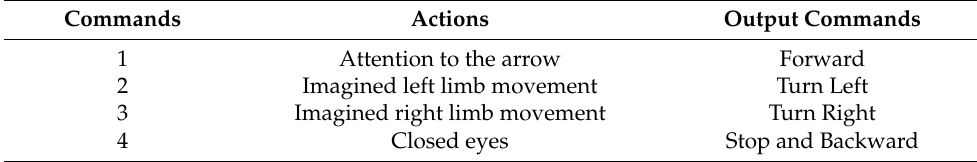
Table 1. Proposed action for mental tasks mapping with output commands.